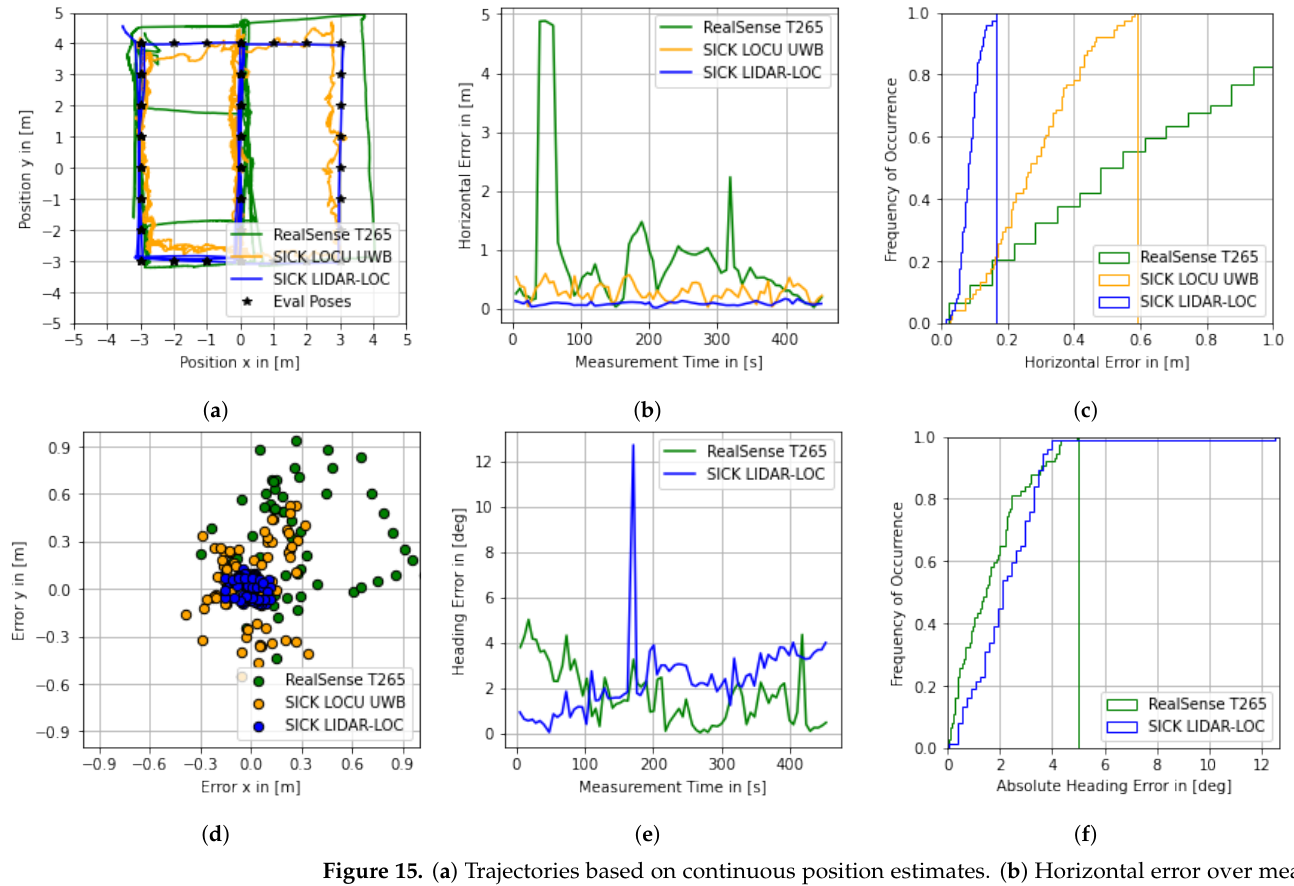
Figure 15. ( a ) Trajectories based on continuous position estimates. ( b ) Horizontal error over mea- surement time. ( c ) Cumulative distribution histogram of the horizontal error. ( d ) Error scatter. ( e ) Heading error over measurement time. ( f ) Cumulative distribution histogram of the absolute heading error. Table 6. Overview of performance metrics. Metrics referred to in the text are marked